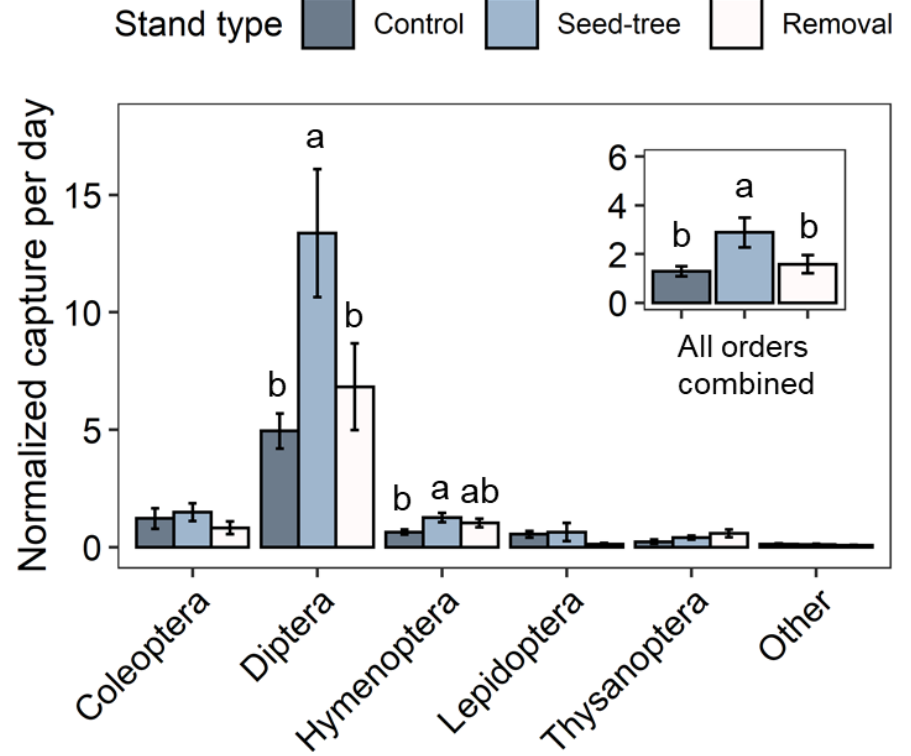
Figure 2. The abundance of insect orders captured under different silvicultural practices (control, seed-tree, and removal treatments) during the black cherry flowering period. The significant effects of stand type on overall abundance (insert, p < 0.001), Diptera ( p = 0.001), and Hymenoptera ( p = 0.016) were detected in repeated measures ANOVA. The least-square means of these groups were compared using the Tukey – Kramer test with adjustment; groups with the same letter are not sig- nificantly different at α =